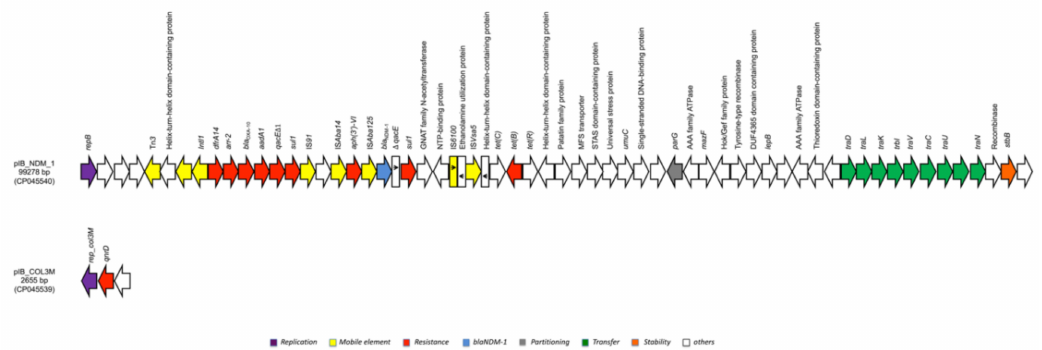
Figure 2. Linear map of pIB_NDM_1 and pIB_COL3M. Arrows show the direction of transcription of open reading frames (ORFs), while rectangles show truncated ORFs. Replicons, mobile elements, antibiotic resistance genes, bla NDM_1 , partitioning genes, conjugal transfer genes, plasmid stability genes, and other remaining genes are designated by violet, yellow, red blue, grey, green, orange, and white,